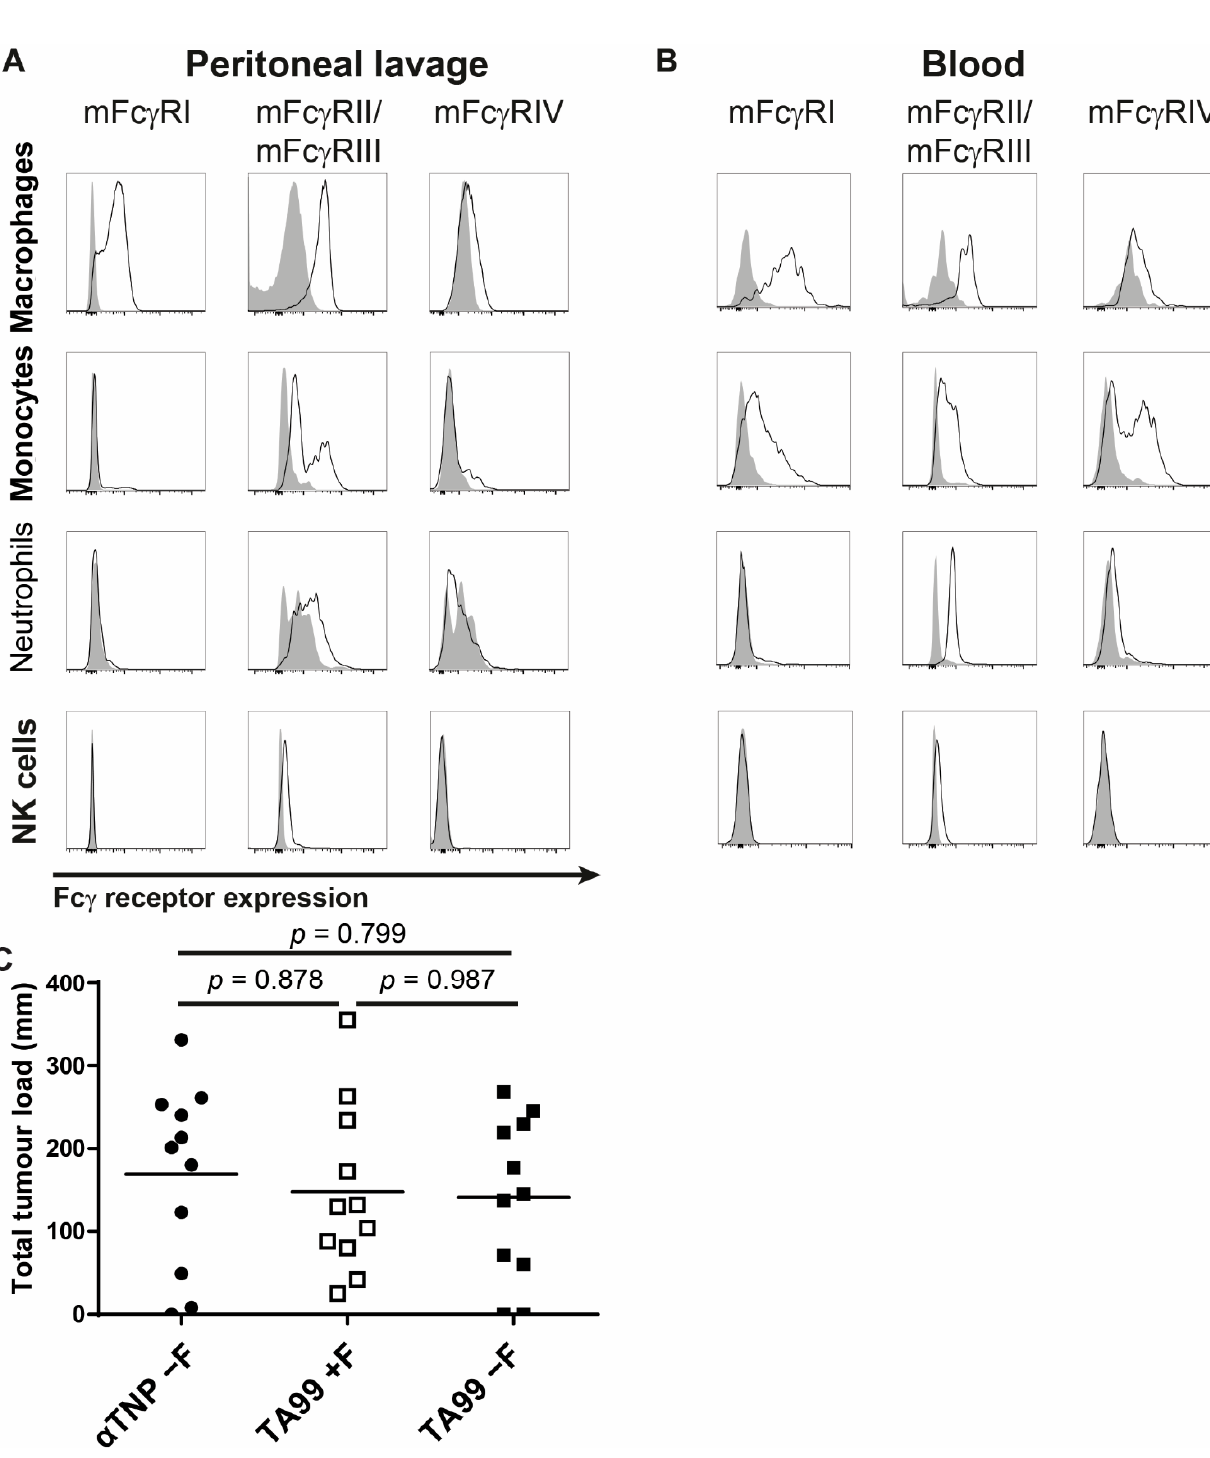
Figure 6. Fc γ RIV is essential in antibody therapy in the peritoneal cavity. ( A , B ) Fc γ receptor expression by effector cells in the peritoneal cavity ( A ) and in blood ( B ). Isotype control is shown in grey, Fc γ R-specific antibodies with a solid line. ( C ) C57Bl/6 mice lacking Fc γ RIV were injected intraperitoneally with 50,000 B16F10-gp75 and 50 µg nonspecific hypo-fucosylated hIgG1-anti-TNP ( ● ) or humanized IgG1-TA99as either fucosylated ( □ ) or hypo-fucosylated ( ∎ ) variant. 14 Days post injection mice were sacrificed and metastasis outgrowth in the peritoneum was scored. N = 11 per group.